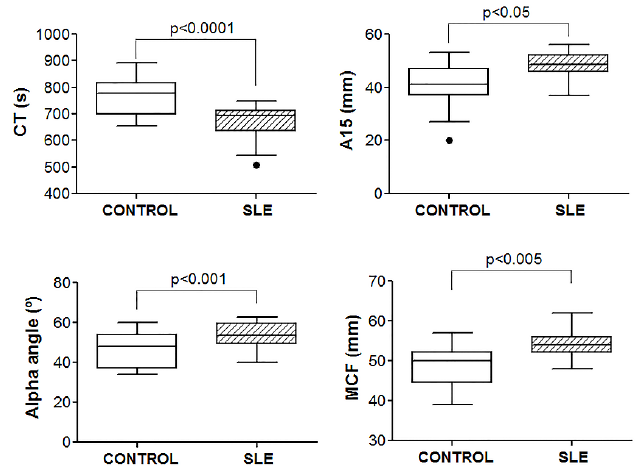
Figure 1. Procoagulant profile in patients with SLE. ROTEM ® thromboelastography was performed in whole blood. Detailed procedures and measured parameters are shown in “Materials and Methods”. Student’s t-test or Mann–Whitney test was performed, and p ≤ 0.05 was set as significant. SLE, systemic lupus erythematosus; CT, clotting time; A15, amplitude at 15 min; MCF, maximum clot firmness.